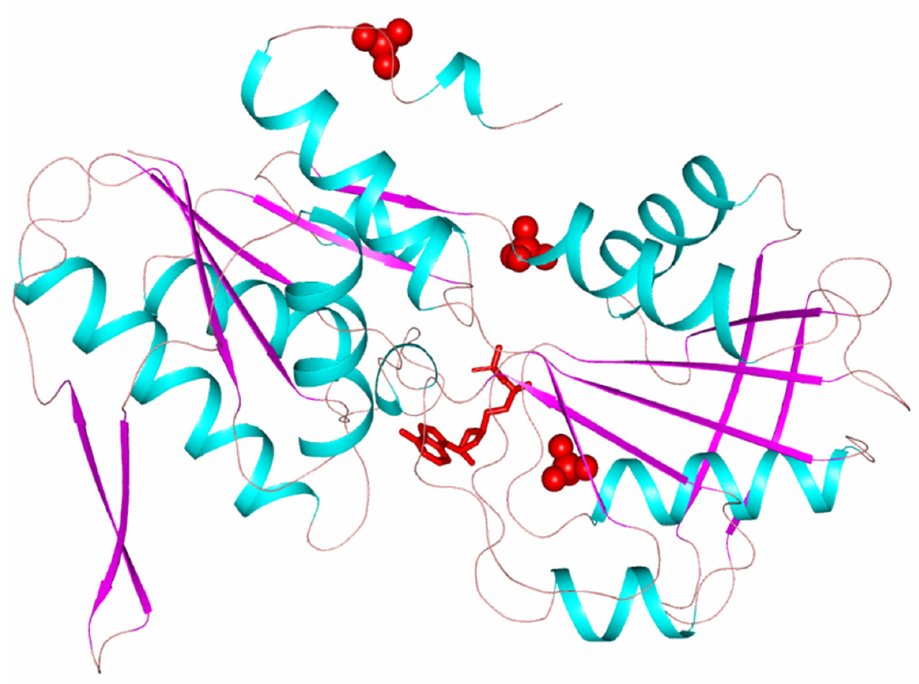
Figure 1. TthPRPPS2 subunit polypeptide chain. Red spheres show sulfate ions. The red sticks show the ADP molecule.